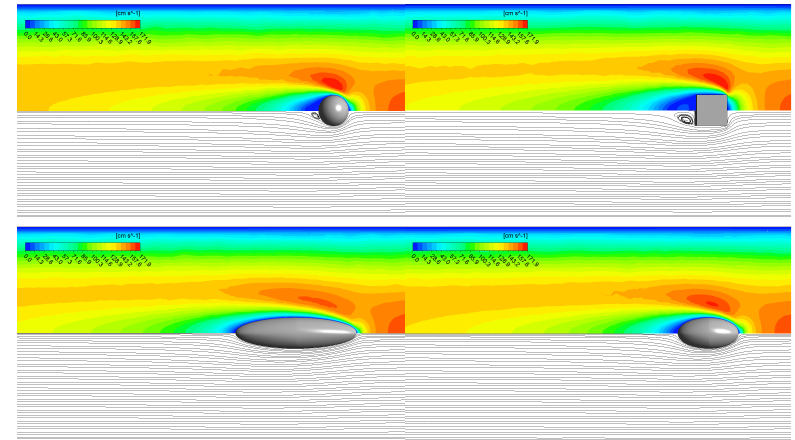
Figure 1. Computational fluid dynamics simulations for a Newtonian fluid around objects with different morphology at Re = 22.3. The flow direction is from right to left. Adapted from